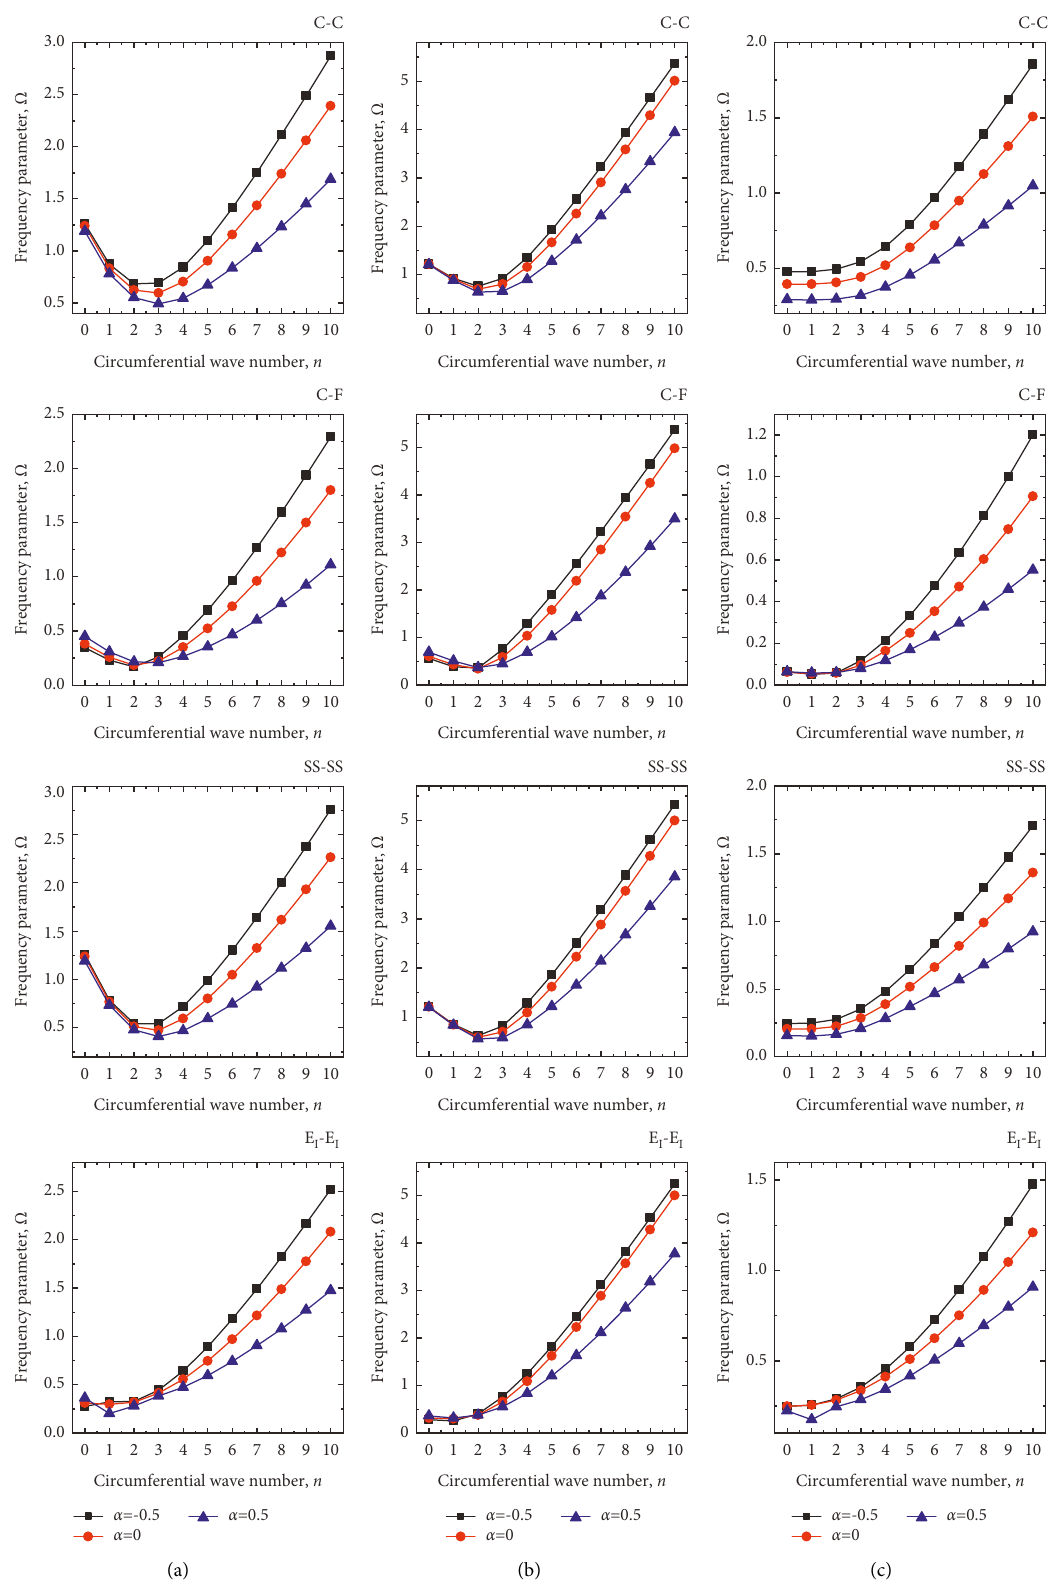
Figure 7: Variation of frequency parameters of laminated composite structures with different circumferential wave number and variable thickness ( m � 1), (a) conical shell, (b) cylindrical shell, and (c) annular